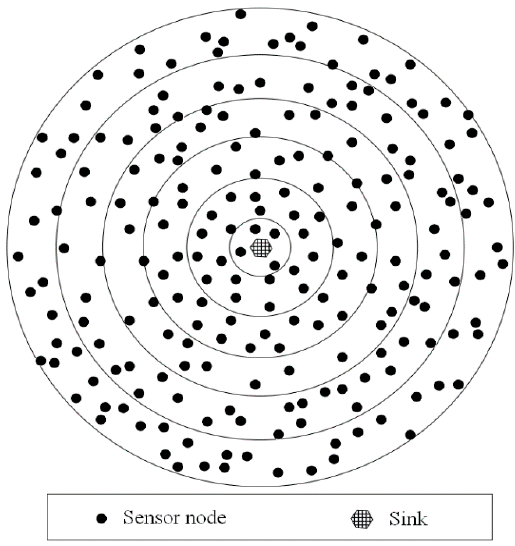
Figure 4. The deployment of sensors in emerging sensor networks.